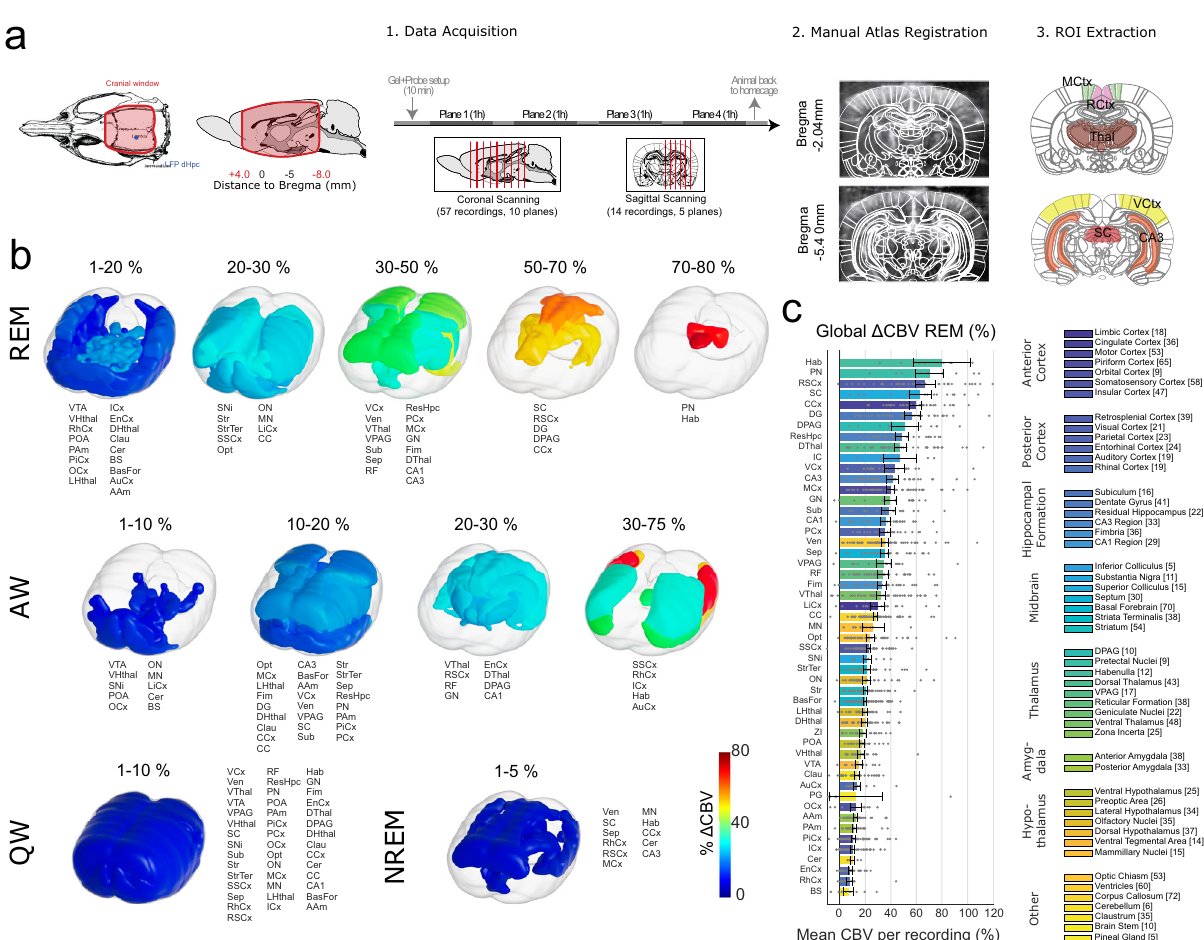
Fig. 1 Volumetric reconstruction of REM sleep network based on sequential planar functional ultrasound imaging. a Data acquisition and analysis pipeline (1) Large cranial window and LFP electrode location. Such chronic preparation yields a large fi eld of view and allow for sequential scanning of the brain on coronal (57 recordings, 10 planes, 3 rats) and parasagittal (14 recordings, 5 planes, 3 rats) planes. (2) A reference atlas is manually registered on each recording using salient landmarks. (3) Masks corresponding to regions of interests are then used to compute mean regional cerebral blood volume (CBV) for de fi ned periods of time. Mean CBV values are then computed across all recordings and rendered in a 3D brain volume. b Volume rendering of the mean values of CBV changes for 4 vigilance states (QW: quiet wake, AW: active wake, NREMS: non-REM sleep, REMS: REM sleep). Note that CBV levels during REMS largely outmatch all other regions. Only regional values above 1% are shown for clarity. Note the strong activations in the superior colliculus, retrosplenial cortex, dentate gyrus, dorsal part of the PAG, cingulate cortex, pretectal nuclei and habenulla. c Bar plots showing the mean CBV changes distributions across regions of interest. Regions have been grouped and color-coded according to relevant brain structures. Gray dots are individual recordings, error bars display standard-deviation (72 recordings, 3 rats). Atlas images adapted from The Rat Brain in Stereotaxic Coordinates: Compact, Paxinos G. and Watson C., Copyright (2017), with permission from Elsevier. (2) manual registration onto an anatomical atlas using salient landmarks, (3) ROI extraction and sleep scoring to fi nally com- pute regional averages of CBV time-series for all vigilance states and fi nally to re-project the mean values onto a 3D volume (Fig. 1a). This revealed a quiescent level of CBV fl uctuations in QW and NREMS in all brain structures. AW however is asso- ciated with increased cortical CBV levels especially in the primary sensory areas, while REMS is characterized by increased CBV in all brain regions with strongest effect in the hippocampal and limbic structures (Fig. 1b). As we aimed at studying in detail the hemodynamic changes in various parts of the brain during REMS, we next quanti fi ed the changes in 56 regions of interest located under our various imaging planes, by computing the percentage of CBV change during REMS (Fig. 1c). Calculations were both performed using 1 – 3 min of either the QW or the AW for the baseline (Supplementary Fig. 4). This double analysis shows consistently a large range of CBV changes in association with COMMUNICATIONS BIOLOGY| (2022) 5:1306